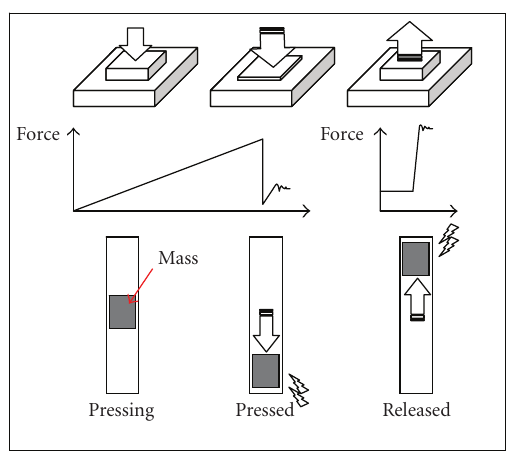
Figure 6: Procedure of button pressing sense.